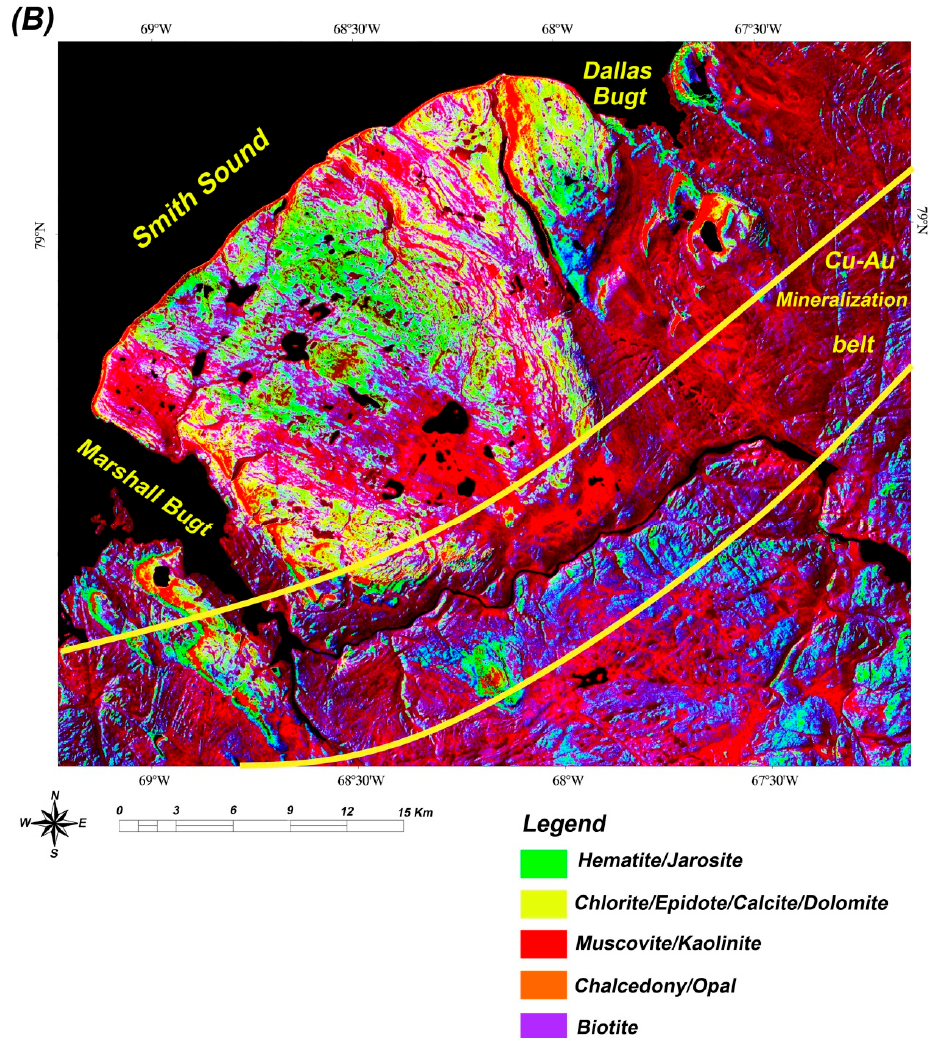
Figure 9. ( A ) The n-D classes (end-member spectra) extracted for a selected spatial subset (ASTER VNIR + SWIR) covering the Cu-Au mineralization belt and surrounding areas. ASTER band center positions are shown. ( B ) ASTER LSU classification mineral map for the selected spatial subset covering the Cu-Au mineralization belt and surrounding areas.